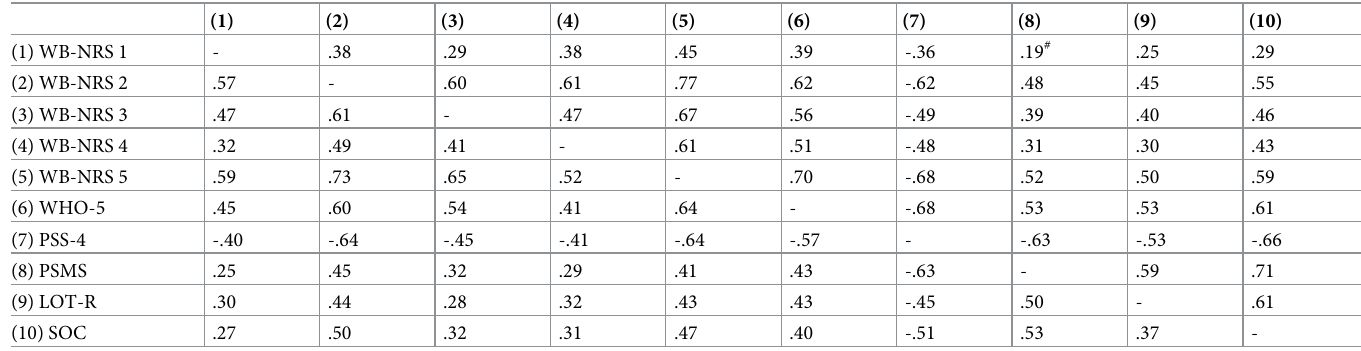
Table 4. Bivariate Bayesian correlates between the Well-being Numerical Rating Scales (WB-NRSs) and the other variables in the study in the non-clinical